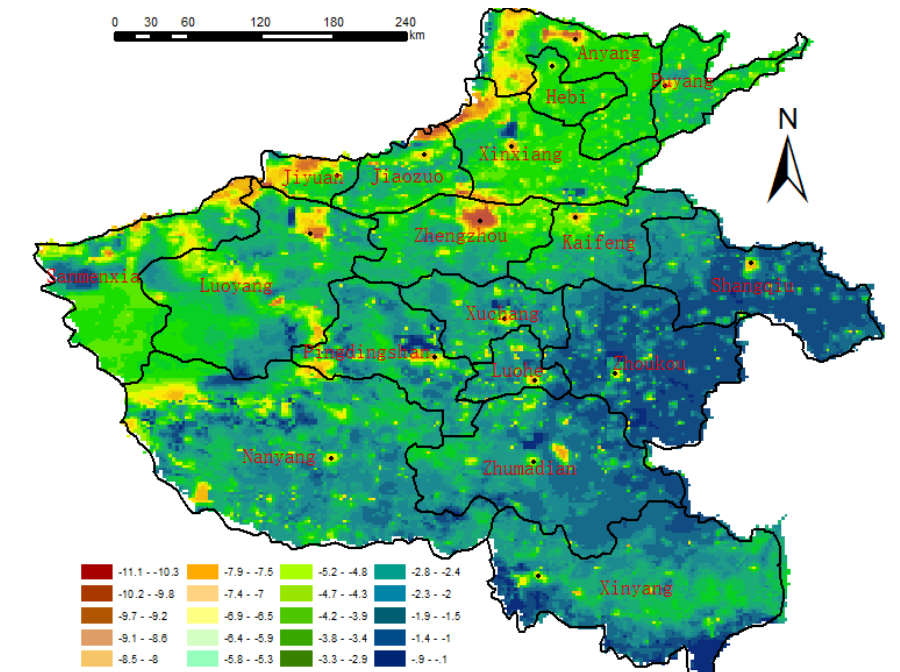
Figure 5. 2007 Henan Province, the city's ED map (point on behalf of the city center or city government